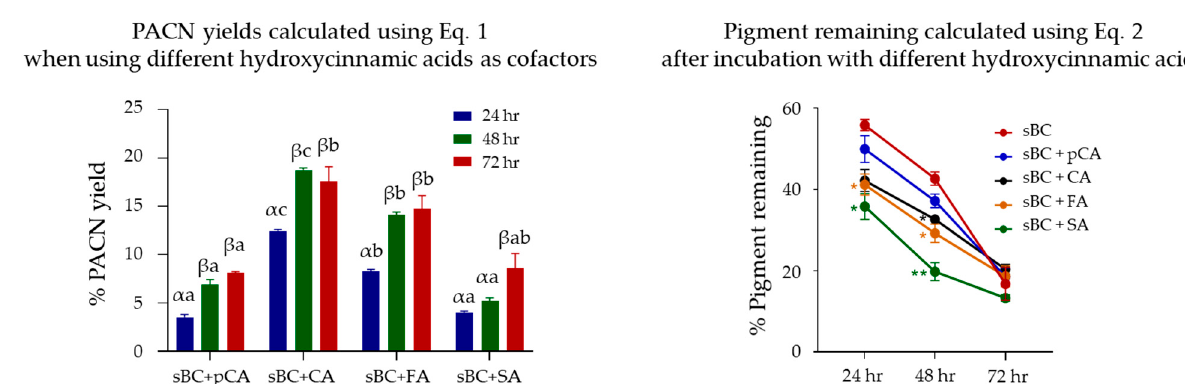
Figure 4. Pyranoanthocyanin yield (%PACN) with different hydroxycinnamic acids and pigment remaining (%) after incubation for 24, 48, and 72 h at 45 ◦ C with cyanidin-glycosides (from saponified black carrot, sBC). Different Greek letters show significant differences among time points at a 0.05 level. Different letters show significant differences among cofactors at the same time point at a 0.05 level. Asterisks (*) and (**) indicate significant differences against the cofactor-free control (sBC) at a 0.05 and 0.01 level, respectively. Results are expressed as means ± standard error ( n = 3). pCA: p -coumaric acid. CA: caffeic acid, FA: ferulic acid, SA: sinapic acid, Eq: equation.